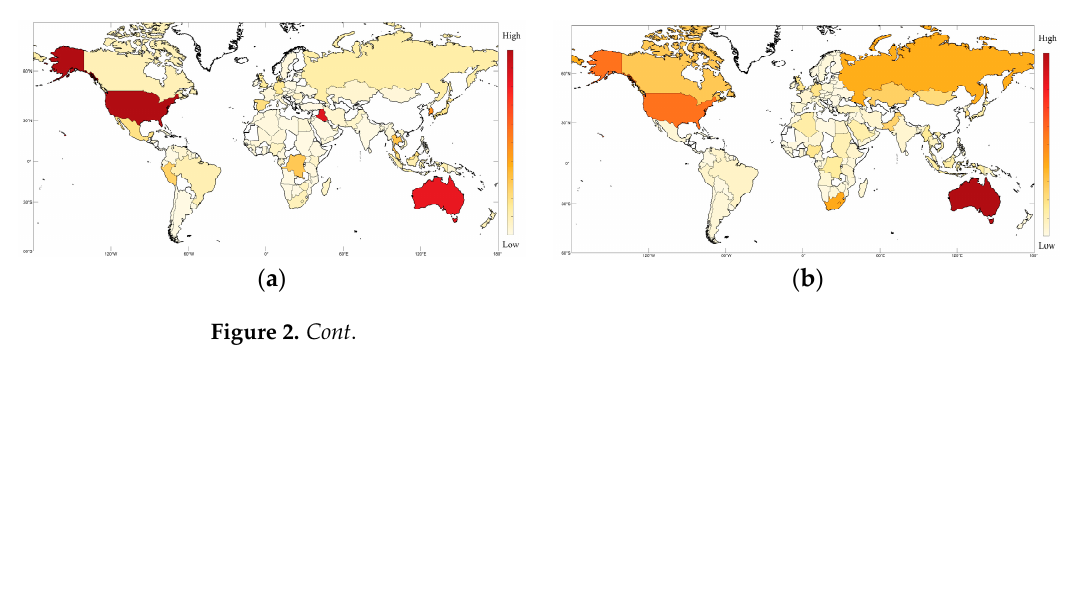
Figure 1. ICRG’s Perennial Change Risk Zoning Map. ( a ) – ( d ) represent ICRG composite risk in 2004, 2009, 2014, 2019.